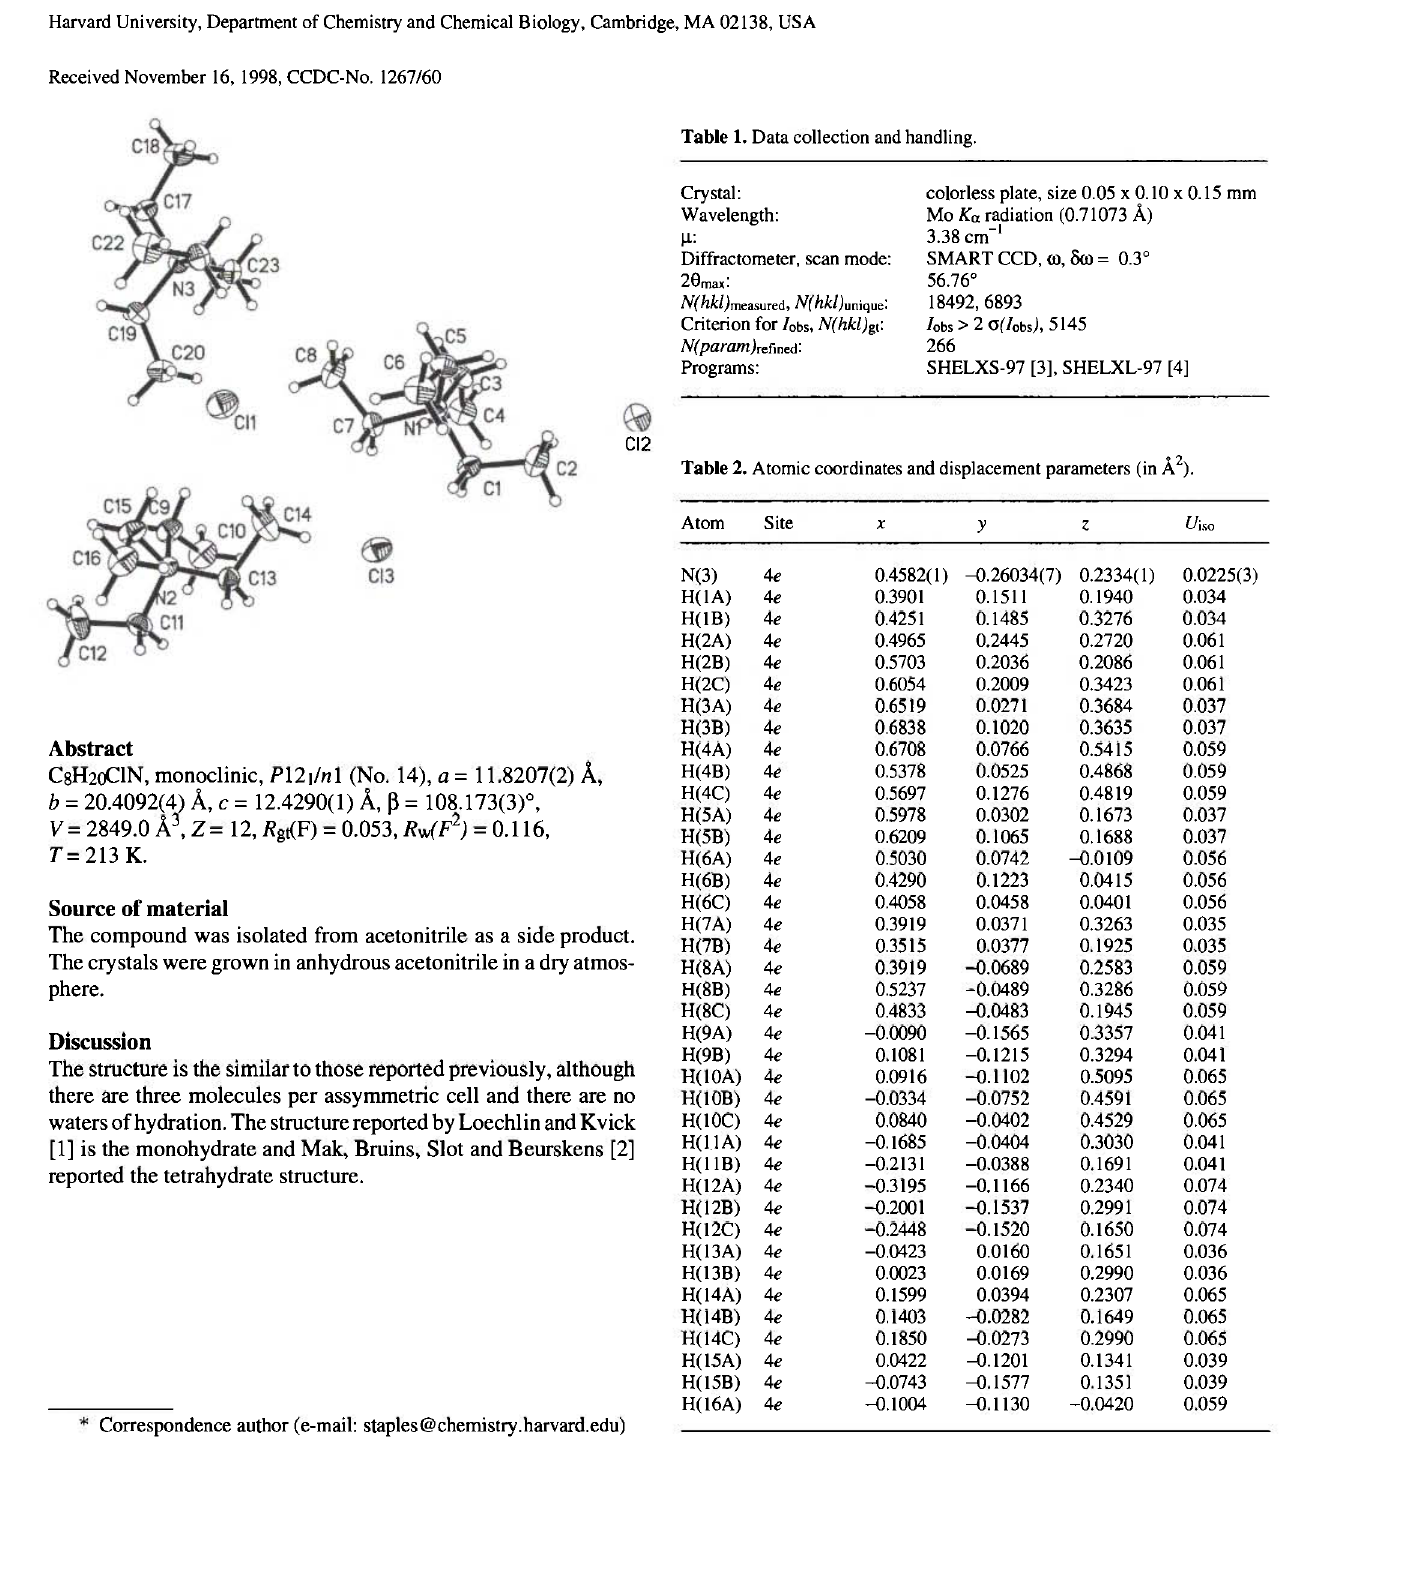
Table 1. Data collection and handling.